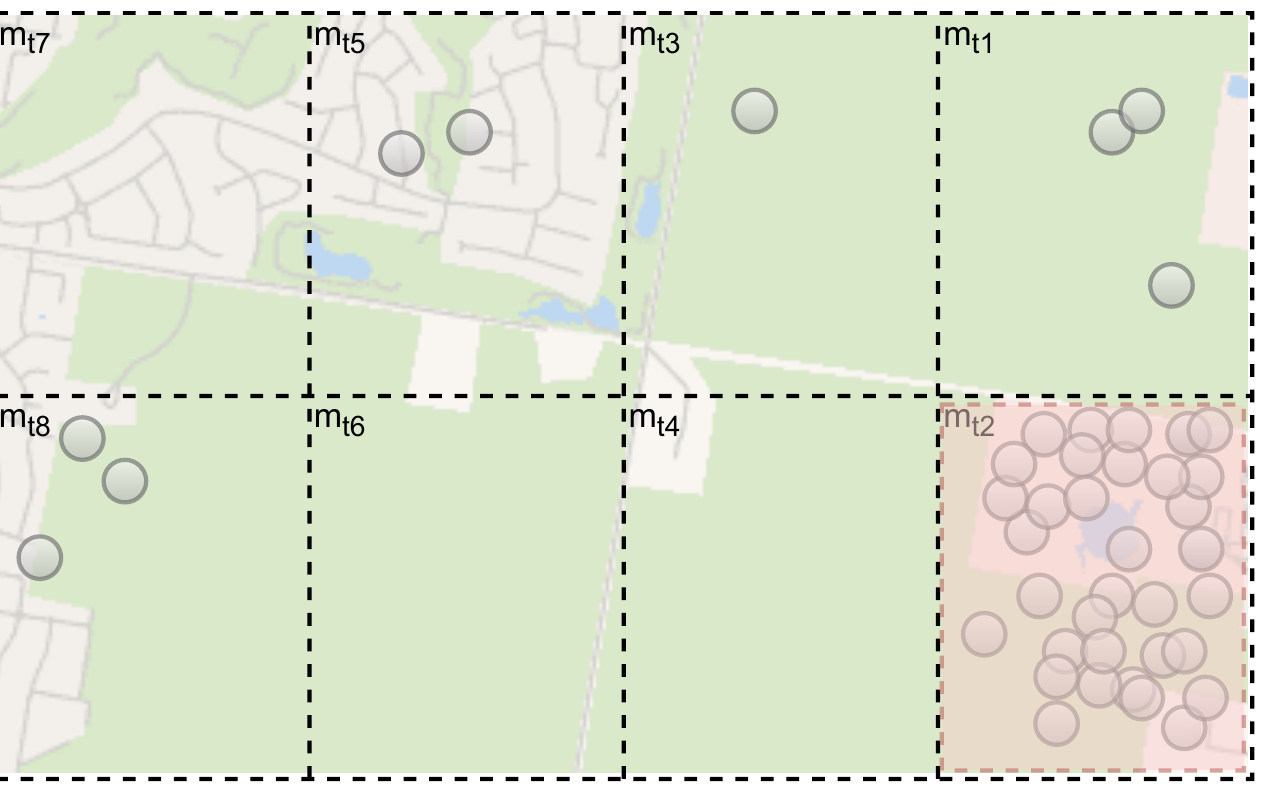
Figure 6. An example: m ti = 36 square meters long, D max ≤